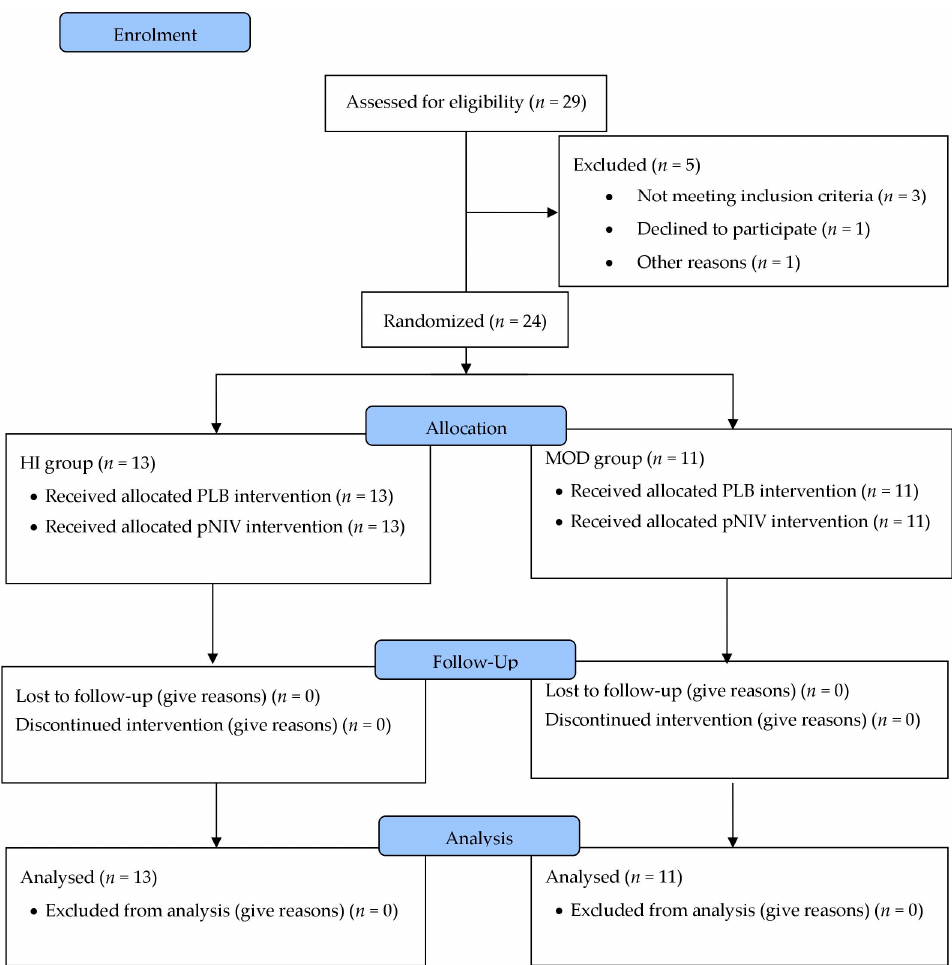
Figure 1. Consort diagram. Following the initial ramp incremental cardiopulmonary exercise test (CPET) to determine WRpeak, 24 patients were randomly allocated either to a high-intensity (HI) or a moderate-intensity (MOD) exercise protocol. Within these two protocols (HI or MOD), each patient performed two more exercise tests using both portable non-invasive ventilation (pNIV) and pursed lip breathing (PLB) during recovery from exercise in balanced order, alternating which test was performed first.